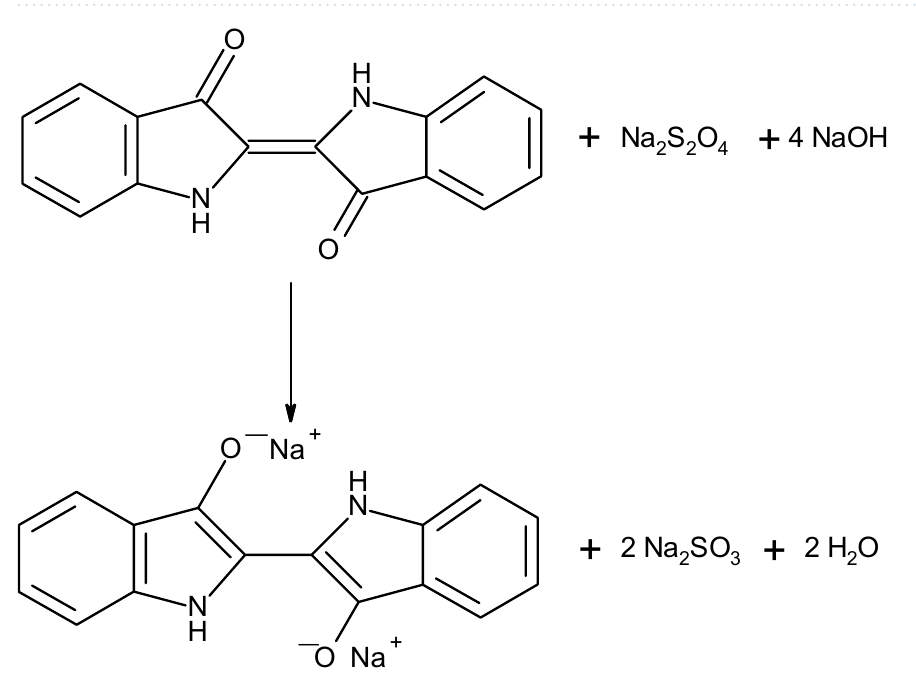
Figure 2. Reduction of indigo to leucoindigo with sodium